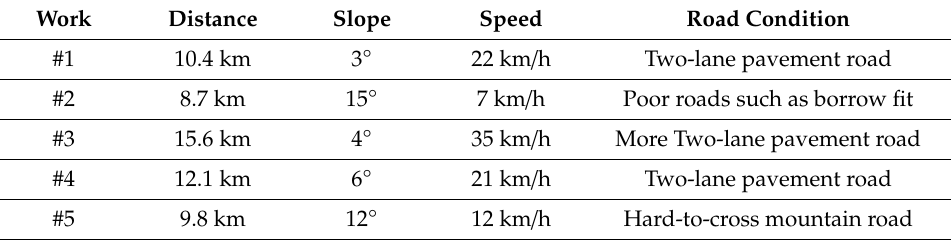
Table 7. Comparing Equipment Paths by